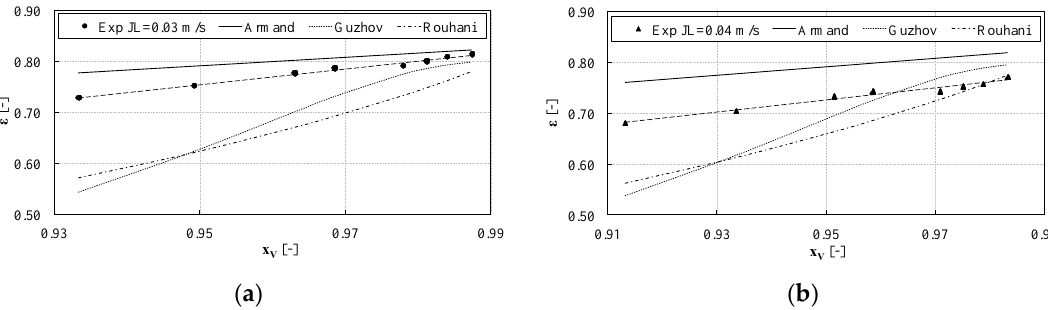
Fluids 2020 , 5 , x Figure 9. Experimental void fraction comparison with models ( a ) 𝐽 𝐿 = 0.03 𝑚/𝑠 and ( b ) 𝐽 𝐿 = 0.04 𝑚/𝑠 . Figure 9. Experimental void fraction comparison with models ( a ) J L = 0.03 m/s and ( b ) J L = 0.04 m/s.